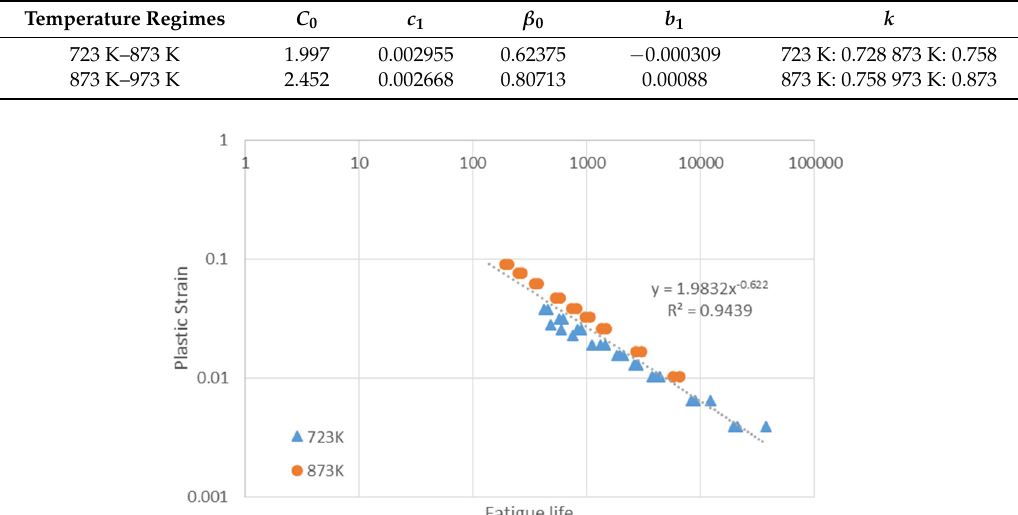
Figure 10. Transformed ε p, ref – N data (above 873 K) of stainless steel 316 using Equation (17). Figures 9 and 10 show that the creep ‐ fatigue data below 873 K and above 873 K can be collapsed into power ‐ law curves of ε (cid:3043),(cid:2928)(cid:2915)(cid:2916) (cid:3404) 1.9832(cid:1840) (cid:2879)(cid:2868).(cid:2874)(cid:2870)(cid:2870) with the quality of fit as R 2 = 0.9439 and ε (cid:3043),(cid:2928)(cid:2915)(cid:2916) (cid:3404) 3.2424(cid:1840) (cid:2879)(cid:2868).(cid:2876)(cid:2873)(cid:2869) with the quality of fit as R 2 = 0.9783 respectively. The errors between fatigue life from experiments and creep ‐ fatigue equation for these two temperature regimes are 0.814 and 0.294. This transformation has verified the creep ‐ fatigue ‐ equation ‐ based temperature modified Coffin ‐ Manson equation.